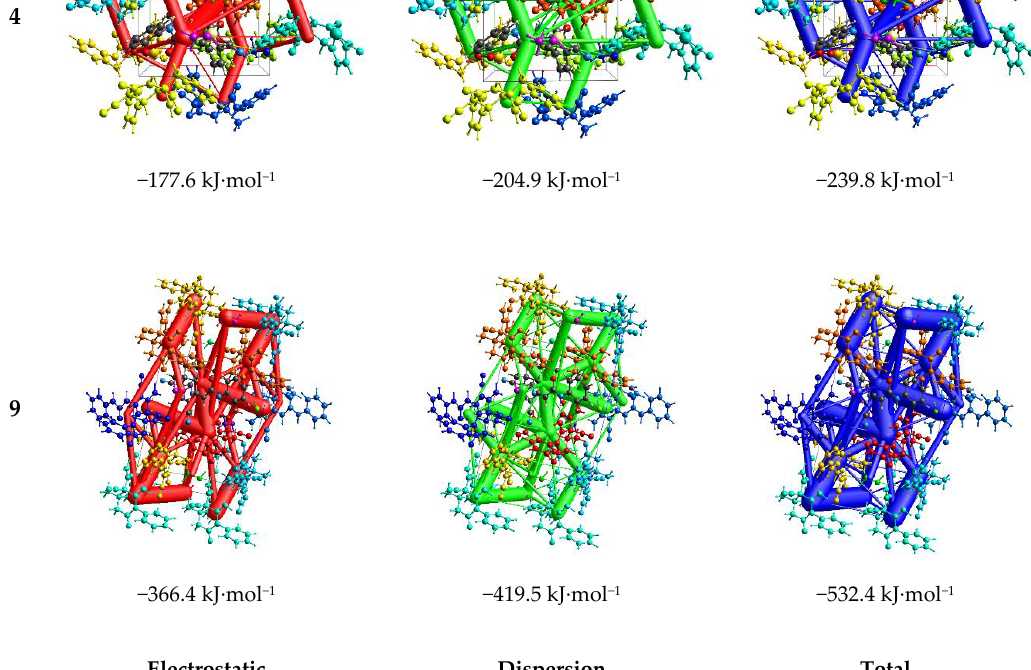
Figure 5. Energy framework diagrams for E ele , E dis and E tot for compounds 2 , 4 , and 9 showing the respective computed energies.